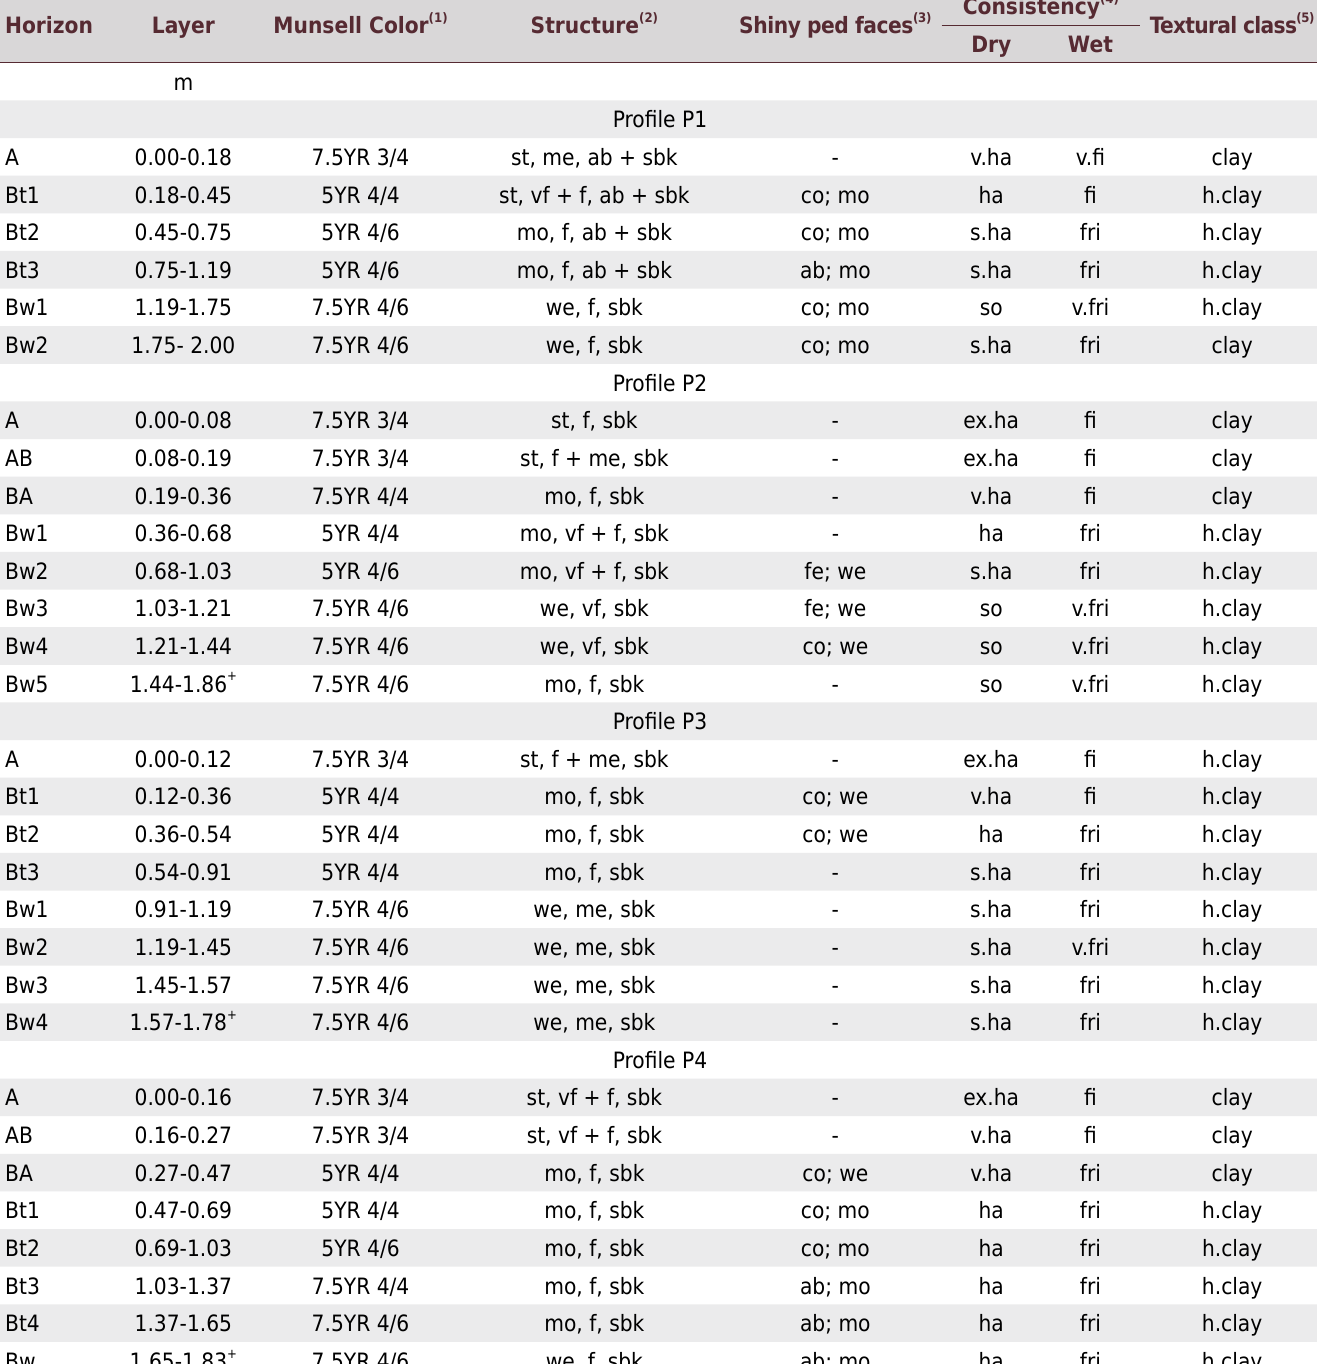
Table 1. Field morphological properties of the sampled soils in the Rio de Janeiro State, Southeastern Brazil Horizon